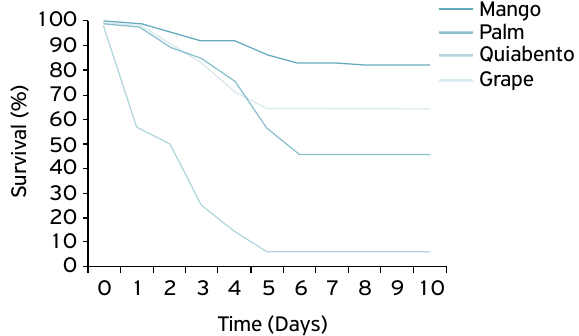
Figure 4. Percentage of survival of larvae C. capitata created in fruit of mango, palm, quiabento and grape. Vitória da Conquista, BA, 2015.